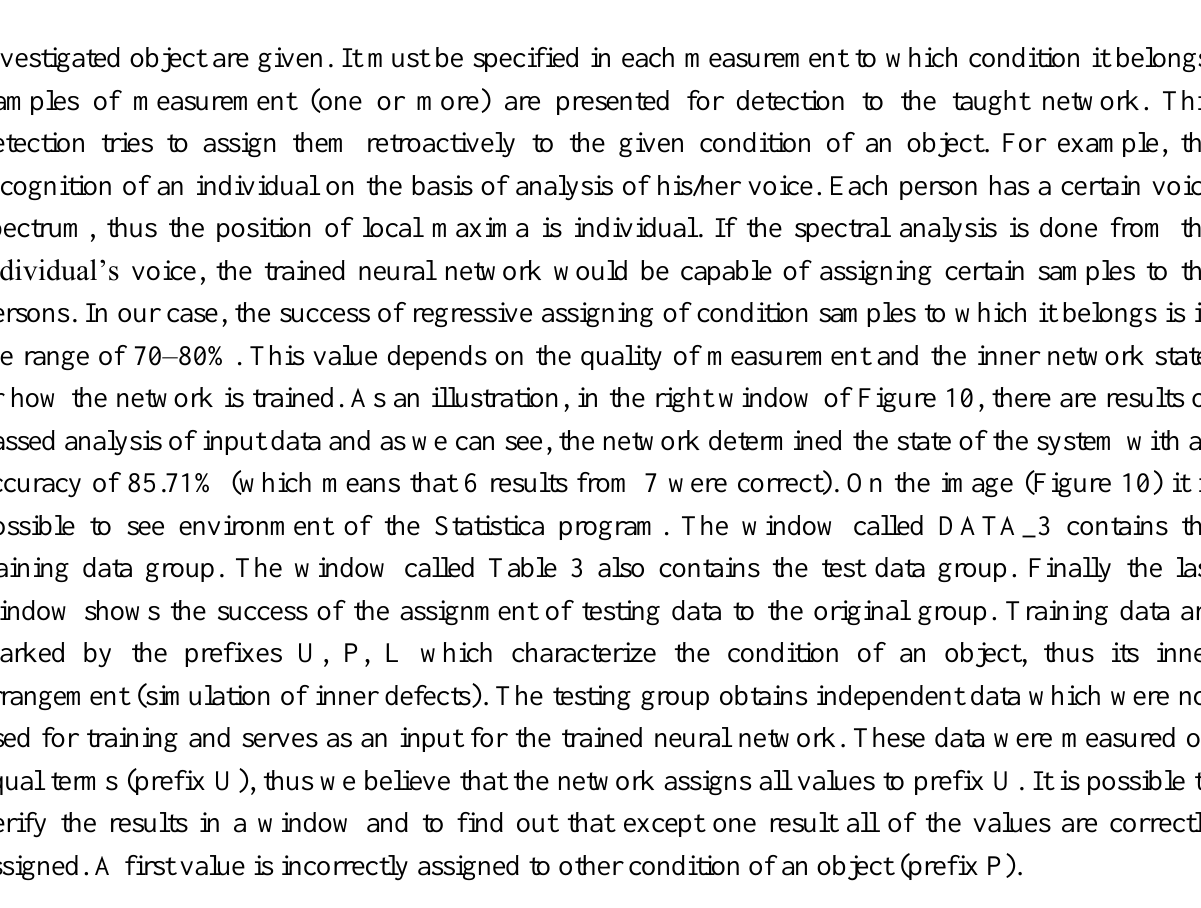
Figure 10. The Statistica program environment and an example of input and output